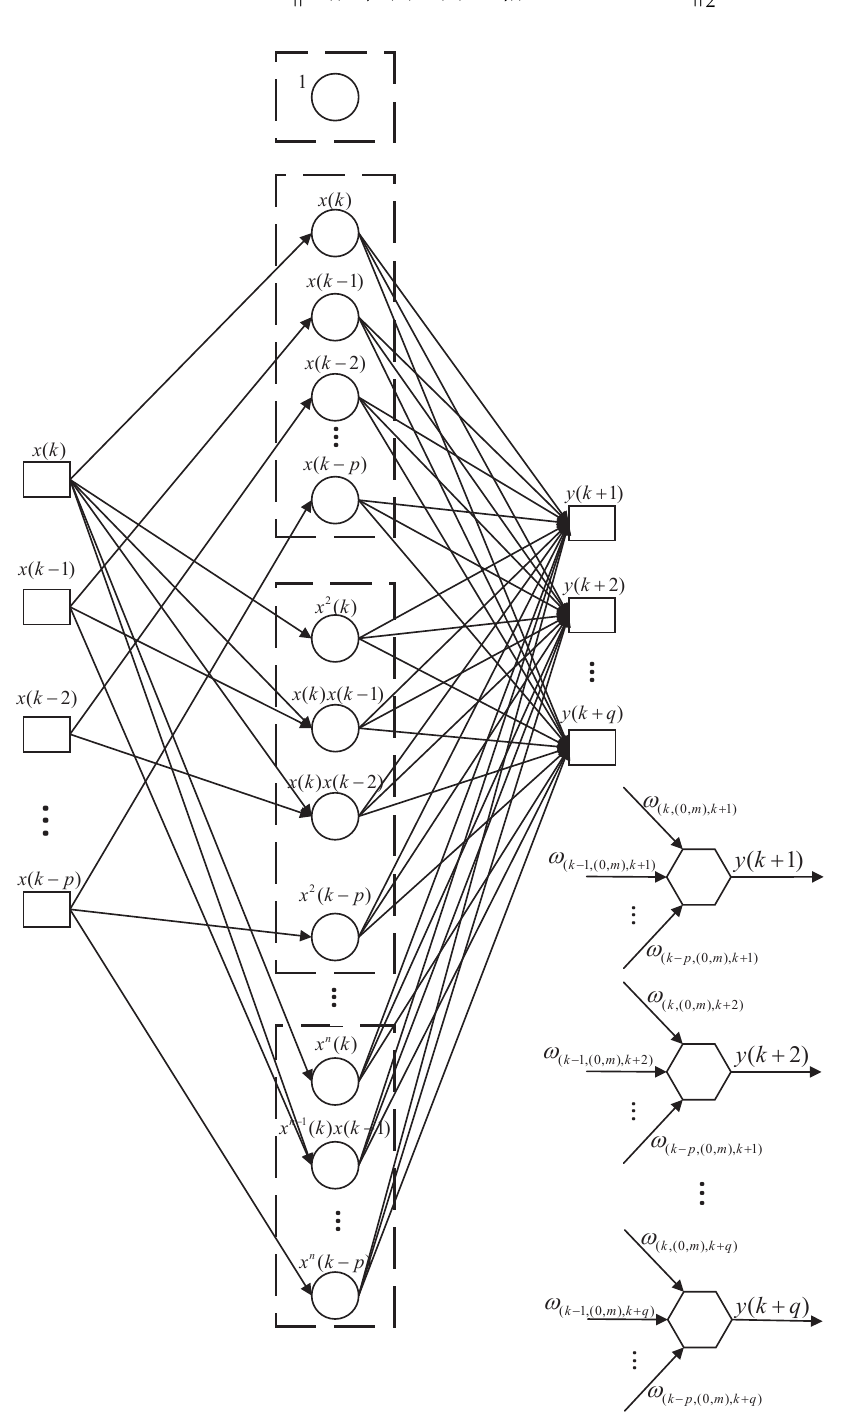
Figure 1. Multi-step prediction structure based on a multi-dimensional Taylor